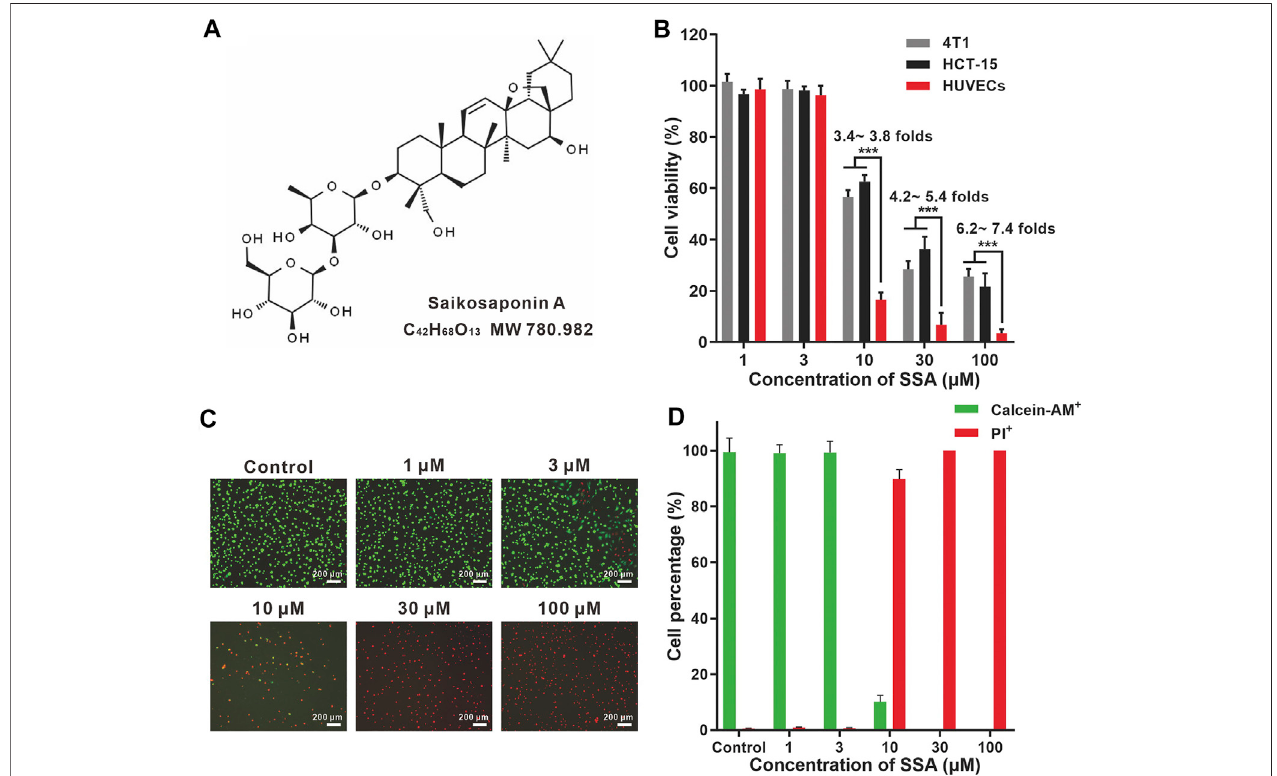
FIGURE 1 | SSA more ef fi ciently suppressed the viabilities of HUVECs compared to those of HCT-15 and 4T1 cells. (A) Chemical structures of SSA. (B) Effect of SSAon cellviability. (C) Representative fl uorescence photographsofHUVECsstainedwithcalcein-AM/PI after treatment withSSA. (D) Thelive(calcein + ) and dead (PI + ) cell percentages of HUVECs after SSA treatments. All values were expressed as mean ± s .d. n (cid:1) 4. *** p <